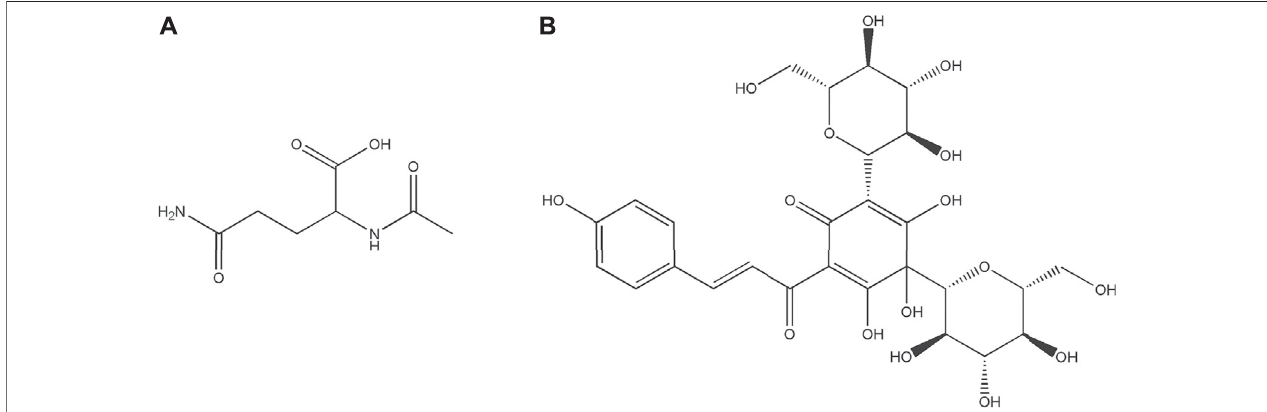
FIGURE 1 | The structures of Acetylglutamine (A) and Hydroxysaf fl or yellow A (B) .